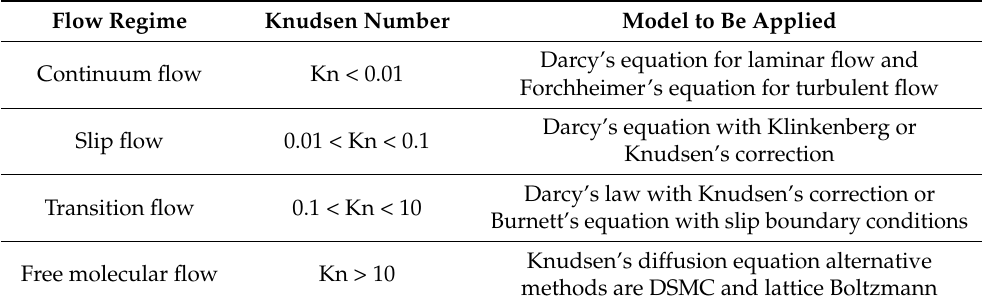
Table 1. Knudsen number and flow regime classifications for porous media